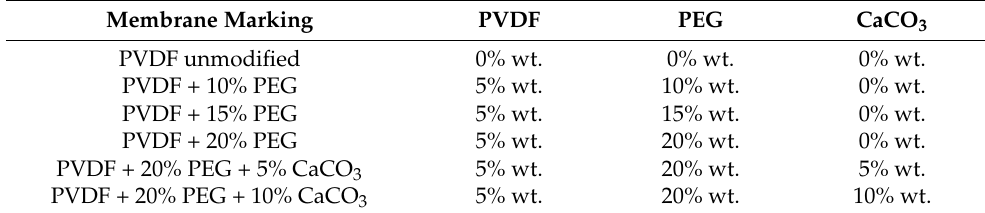
Table 1. Compositions of membrane modification